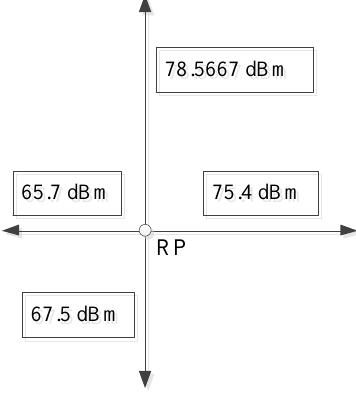
Figure 5. Signal strength observed from four sampling directions.